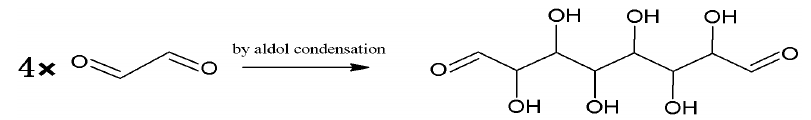
Table 3. Proposed oligomer structures for the MALDI ToF spectra peaks in Figure 8 for the furanic- glyoxal